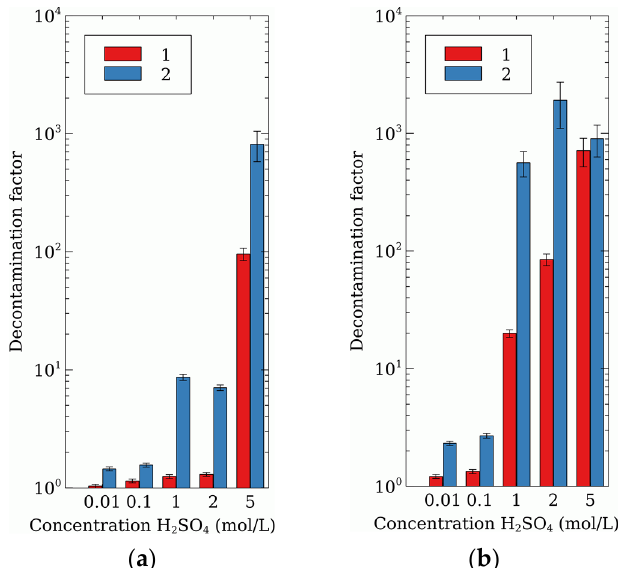
Figure 7. The effect of additional washing of the resins with 3 M NaNO 3 solution on the DF value. ( a ) 25 °C, ( b ) 50 °C. 1—DF values after contact with H 2 SO 4 , 2—DF values after washing with NaNO 3 solution.